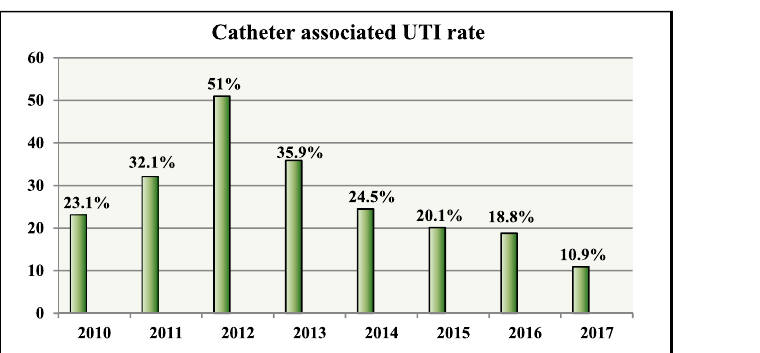
Fig. 2. Ventilator-associated pneumonia rate from 2010-2017